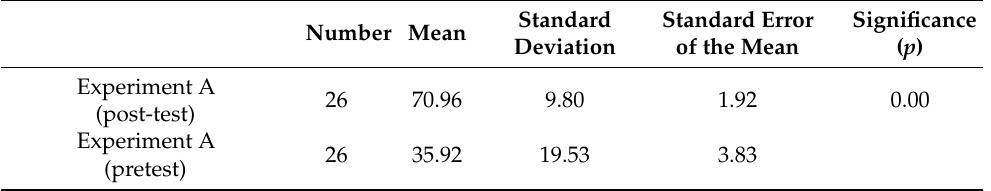
Table 3. Pretest and post-test t -test analyses of Experimental group A.